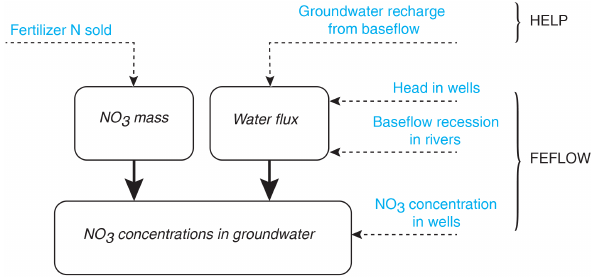
Figure 9. Schematic of the constraints exerted by conditions con- sidered (in blue) in the calibration of model parameters for the simulation of processes controlling groundwater nitrate concentra- tion (NO 3 mass leached and water fluxes, including recharge and groundwater